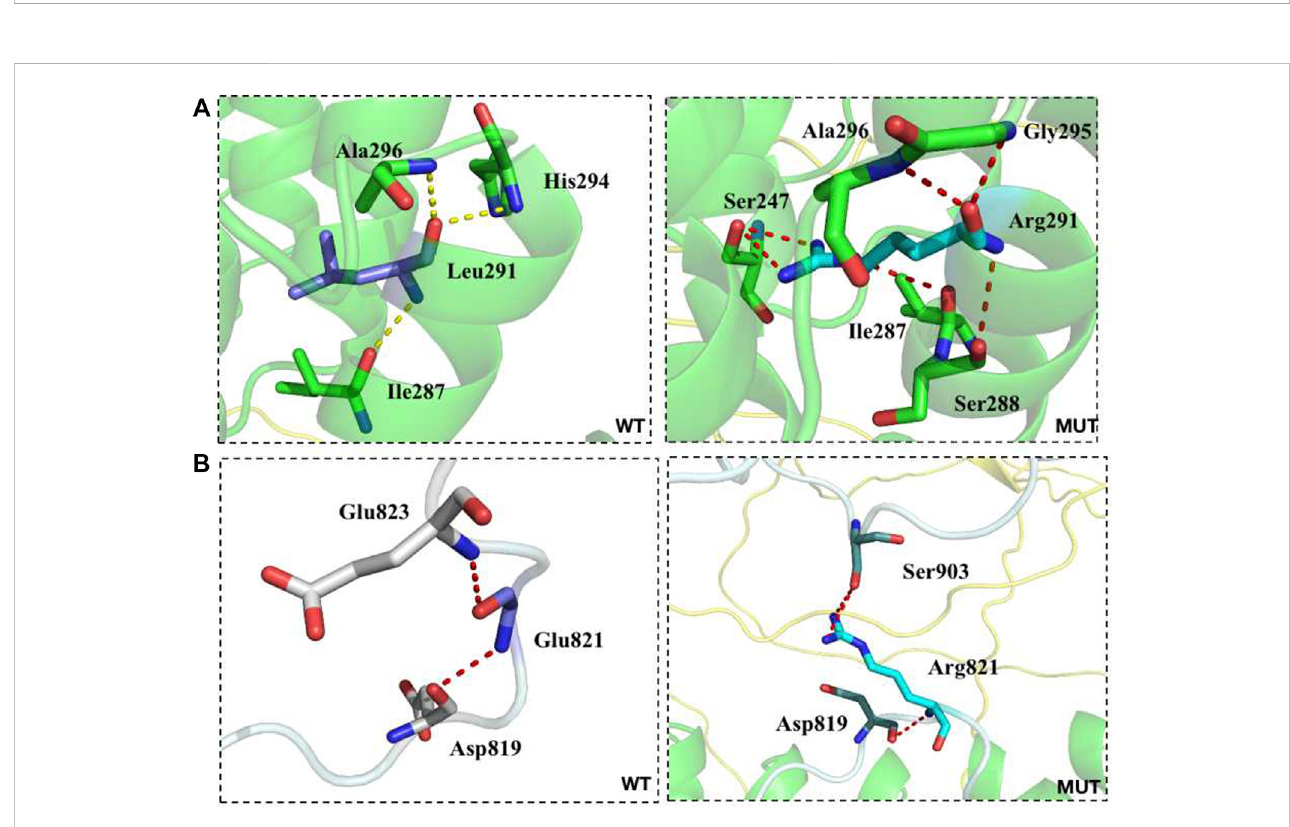
FIGURE 3 The transformation of amino acid hydrogen bonding force after mutation of L291R (A) and G821R (B) .